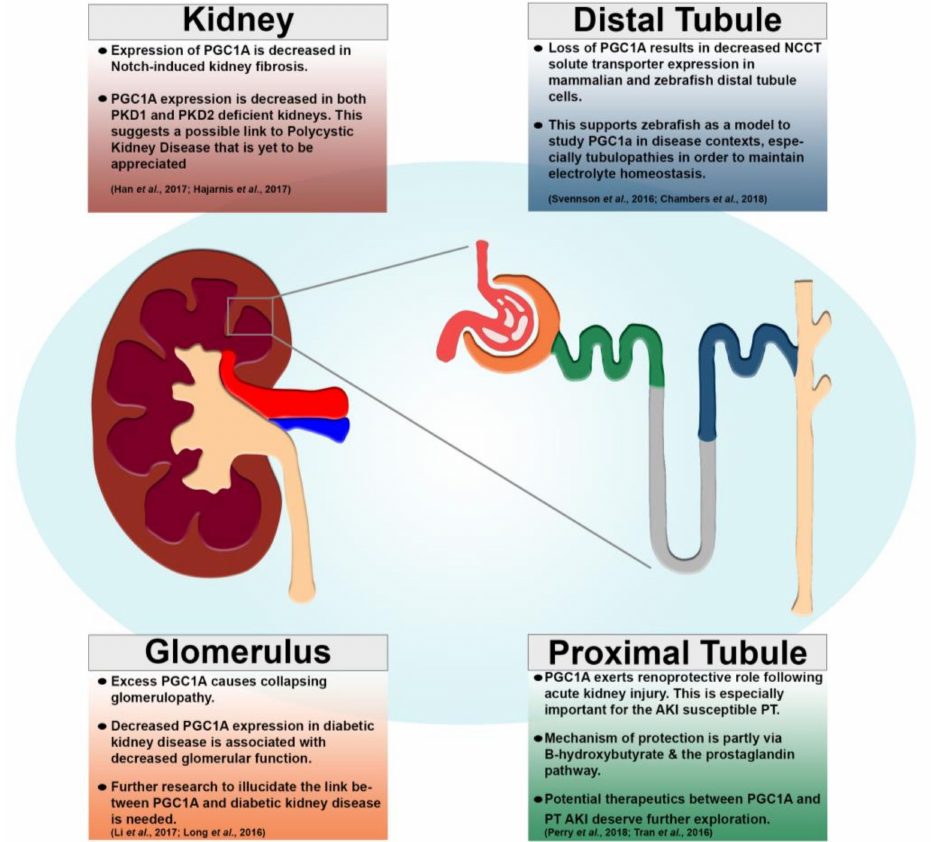
Figure 2. Kidney disease states associated with PGC-1 α expression. Renal diagram illustrating general (top, left) and nephron compartment-specific functions of PGC-1 α in addition to areas of future research. Kidney (left, maroon), nephron (right), glomerulus (orange), proximal tubule (green), and distal tubule (dark blue). References for cited studies listed within. (PT = proximal tubule, AKI = acute kidney